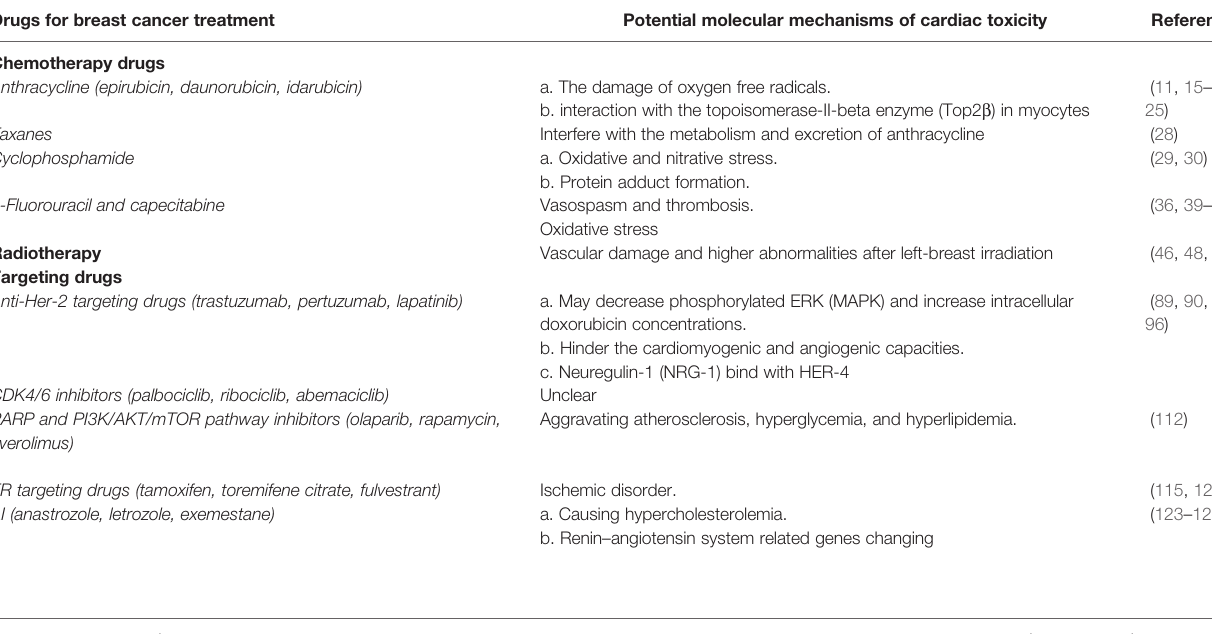
TABLE 2 | The published potential molecular biological mechanisms of cardiotoxicity for breast cancer adjuvant treatment. Drugs for breast cancer